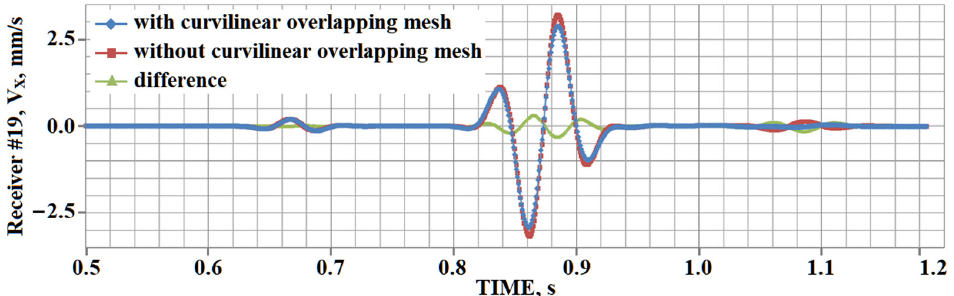
Figure 19. Receiver #19, dependencies of X-component of velocity on time.